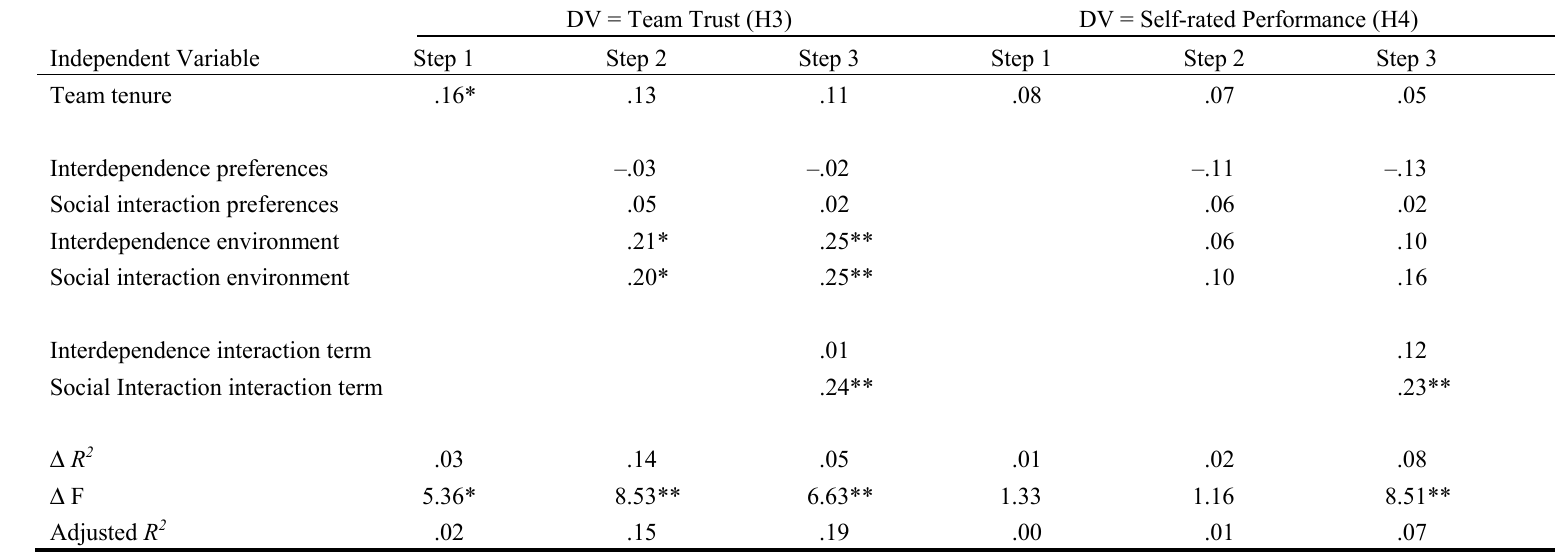
Table 3. Results of hierarchical moderated regression analyses: team trust and self-rated